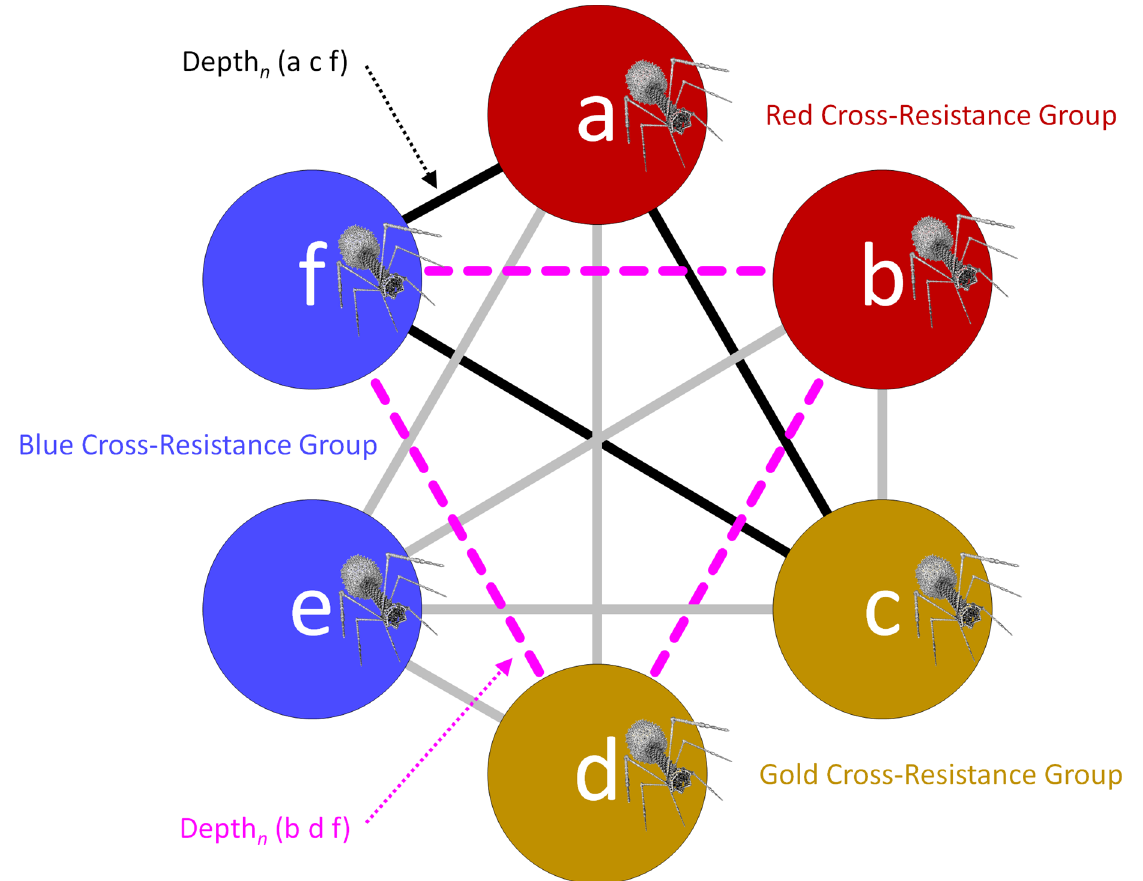
Figure 4. Calculating Breadth 2 without all phages being found in different cross-resistance groups. Phages a through f are found in three different cross-resistance groups, red, gold, and blue, i.e., as presented equivalently in Figure 3. Thick lines between phages serve as guides as to what phage combinations (sub-cocktails) would be involved in Equation 2-based calculations. As examples, note the lines between phages a, c, and f (black-solid) or between phages b, d, and f (purple-dashed). The respective Depth n (a c f) and Depth n (b d f) values are either a 0, 1, 2, or 3. This is 0 if no phages from a given combination hit an individual tested bacterial strain ( n ), 1 if only one hits, 2 if two hit, and 3 if three hit. Considering all six of these phages, then Breadth 2 (a b c d e f) = { ∑ (cid:3041) (cid:2869) True 2 [Depth n (a c e), Depth n (a c f), Depth n (a d e), Depth n (a d f), Depth n (b c e), Depth n (b c f), Depth n (b d e), Depth n (b d f)] }/ n . This is every possible combination of phages acting on